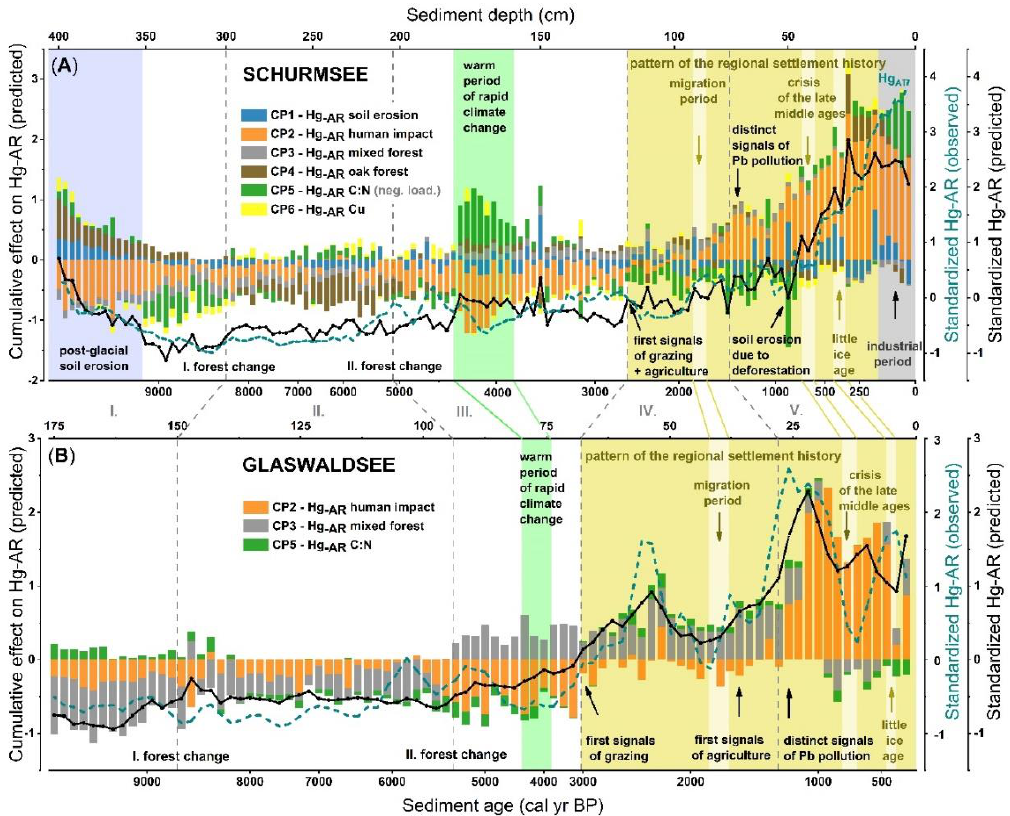
Figure 4. Chronology of the cumulative effects (coloured stacked bars) of the significant factors (CP-Hg-AR) involved in the variations of Hg accumulation (Hg-AR) at Schurmsee ( A ) and Glaswaldsee ( B ) by a lake-specific age-depth distribution. The patterns of climate and local settlement history, records of observed standardized Hg-AR (grey-blue dashed line) and predicted standardized Hg-AR (black line) were obtained by PCR models 1a and 2a.